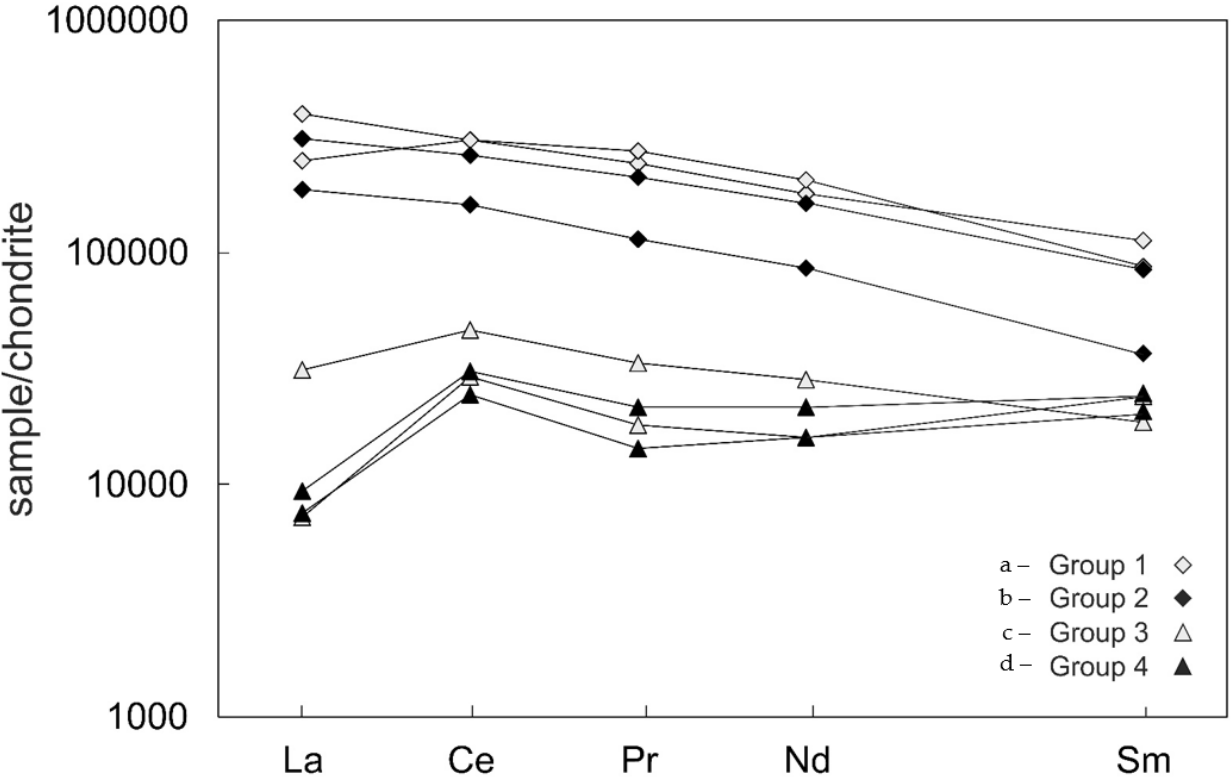
Figure 3. Chondrite-normalized REE patterns for ( a ) unaltered chevkinite-(Ce) (Group 1), ( b ) partially Figure 3. Chondrite ‐ normalized REE patterns for ( a ) unaltered chevkinite ‐ (Ce) (Group 1), ( b ) par ‐ altered chevkinite-(Ce) (Group 2), ( c ) the Pb-Ti-Fe-Si phase (Group 3), and ( d ) the Pb-Ti-Fe-Si phase tially altered chevkinite ‐ (Ce) (Group 2), ( c ) the Pb ‐ Ti ‐ Fe ‐ Si phase (Group 3), and ( d ) the Pb ‐ Ti ‐ Fe ‐ Si (Group 4). Normalization factors from Sun and McDonough phase (Group 4). Normalization factors from Sun and McDonough [8].